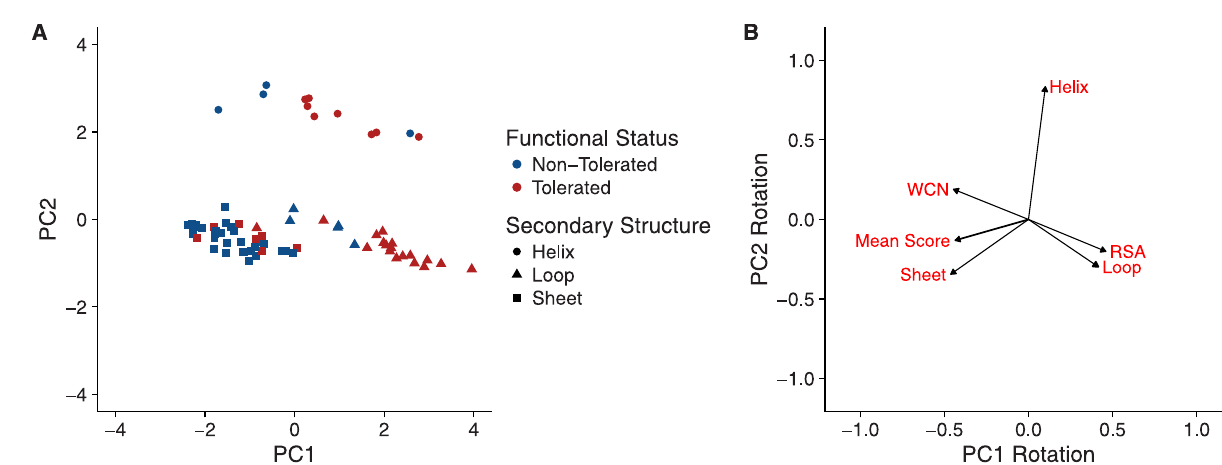
Fig 5. Principal Components Analysis (PCA) of the deletion dataset. (A) Deletionmutants mapped into principal componentsspace. PC1 separates tolerated from non-tolerated mutations, whilePC2 separates deletionsin helices from deletionsin other secondary-structure elements. (B) Visualization of the rotation matrix for the first two principalcomponents.RSA, WCN, and secondary-structure category “Loop” are nearly collinearand primarily (but not entirely) load onto PC1. Helix is nearly orthogonalto this directionand loads primarily only PC2.